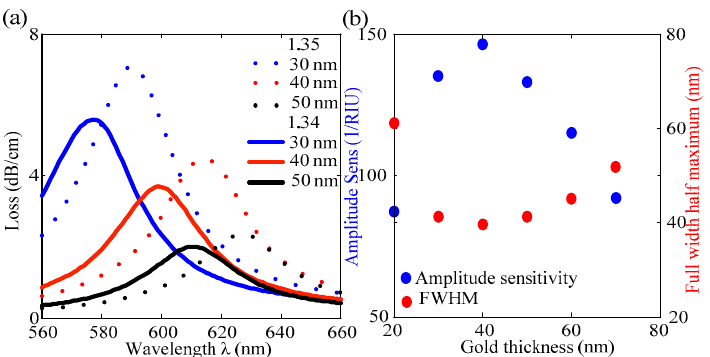
Figure 5. Effect of gold layer thickness: ( a )loss spectra for analyte RI of 1.34, and 1.35, and ( b )amplitude sensitivity and FWHM as a function of gold layer thickness for analyte RI = 1.34.